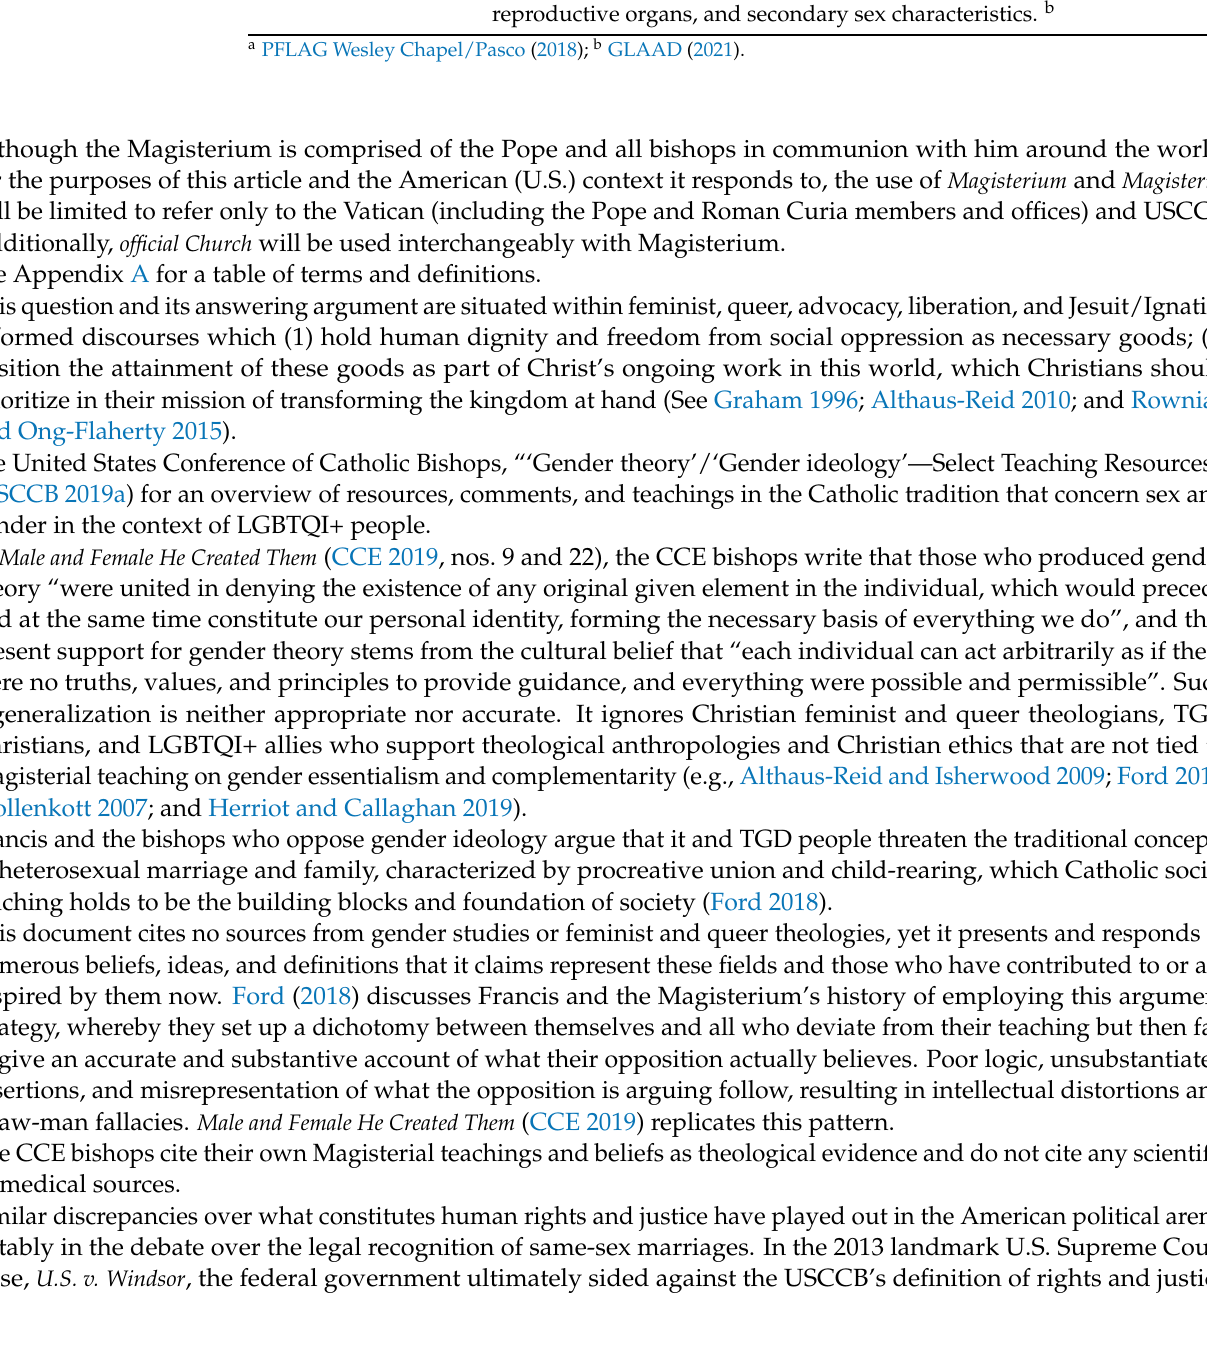
Table A1. Cont . Term Definition Often used as an umbrella term for anyone whose gender identity differs from their sex assigned at birth. Some transgender people choose to modify their bodies with or without hormone therapy and/or surgery, so Transgender (trans) that their bodies and gender expressions are brought into alignment with their gender identity. Not all transgender people wish to change their physical appearance, and sexual orientation is not linked to transgender identity. b Sometimes referred to as biological sex or sex assigned at birth , this is the classification of a person as either male or female based upon an Sex assessment of external genitals at birth. Sex is more fully characterized by a combination of chromosomes, hormones, internal and external reproductive organs, and secondary sex characteristics.